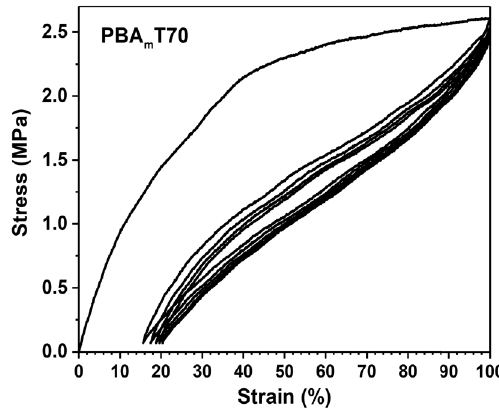
Figure 5: Cyclic stretching curve of PBA m